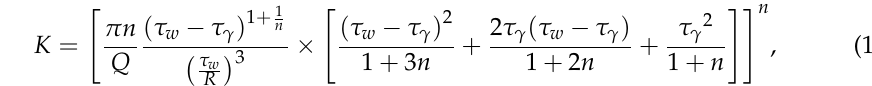
Figure 5. Estimations of K using 10% of the measured obtained by taking the median of the calculations. Here, K = 0.219 Pa.s n , which is an acceptable initial value considering that the consistency index measured with the scientific rheometer was 0.272 Pa.s n